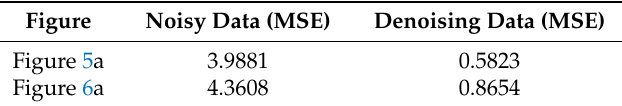
Table 1. Performance of the proposed method. Figure Noisy Data (MSE)